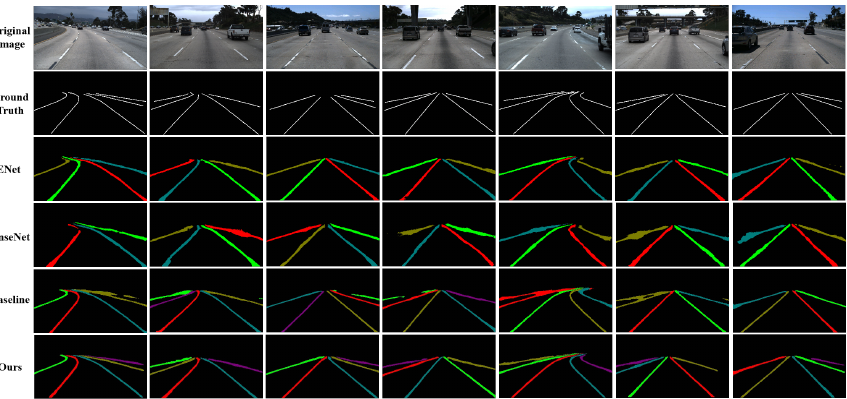
Figure 6. The visualization results of lane mark detection on the Tusimple dataset. We compare the proposed method with ENet [39], DenseNet [48], and our single-frame baseline. The color of lane marks is random, only for distinguishing different lane mark instances.